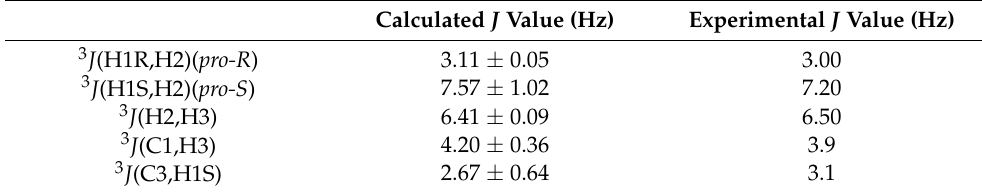
Table 3. Comparison of calculated and experimental coupling constants of ribitol. Calculated J values are obtained from the average of three independent MD simulations (mean ±